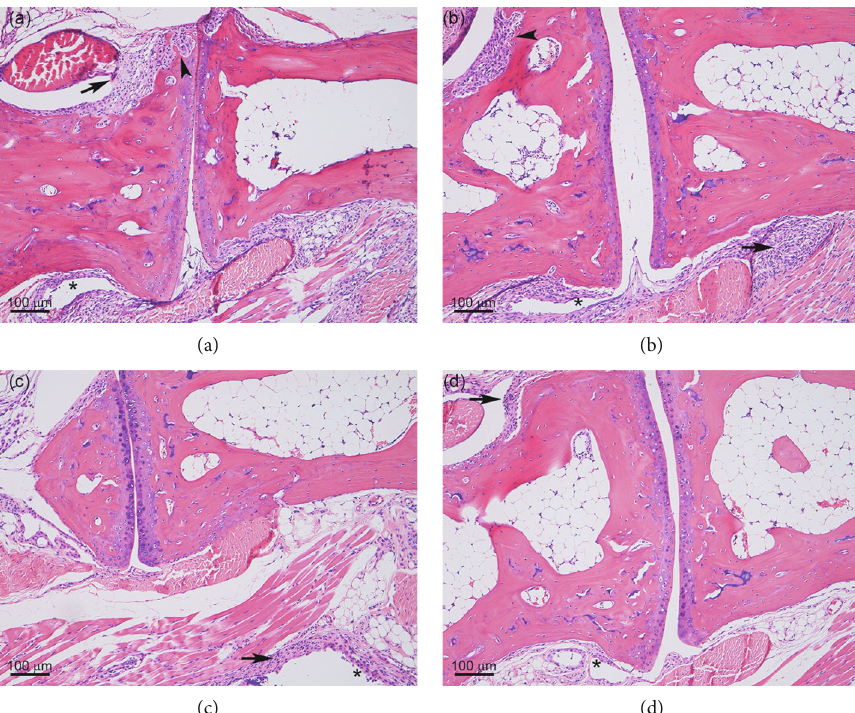
Figure 2: Concomitant treatment with etanercept and tacrolimus attenuates the joint damage in hTNF-Tg mice. Representative H&E-stained sections of the carpal joints from hTNF-Tg mice following treatment with (a) vehicle, (b) etanercept, (c) tacrolimus, and (d) etanercept plus tacrolimus are shown. Arrows, arrowheads, and asterisks in H&E-stained sections indicate in fi ltration of in fl ammatory cells, bone destruction, and synovial hyperplasia, respectively. Table 1: Etanercept with concomitantly administered tacrolimus attenuates the in fl ammatory cell in fi ltration into the synovial lining in hTNF-Tg mice. Parameter